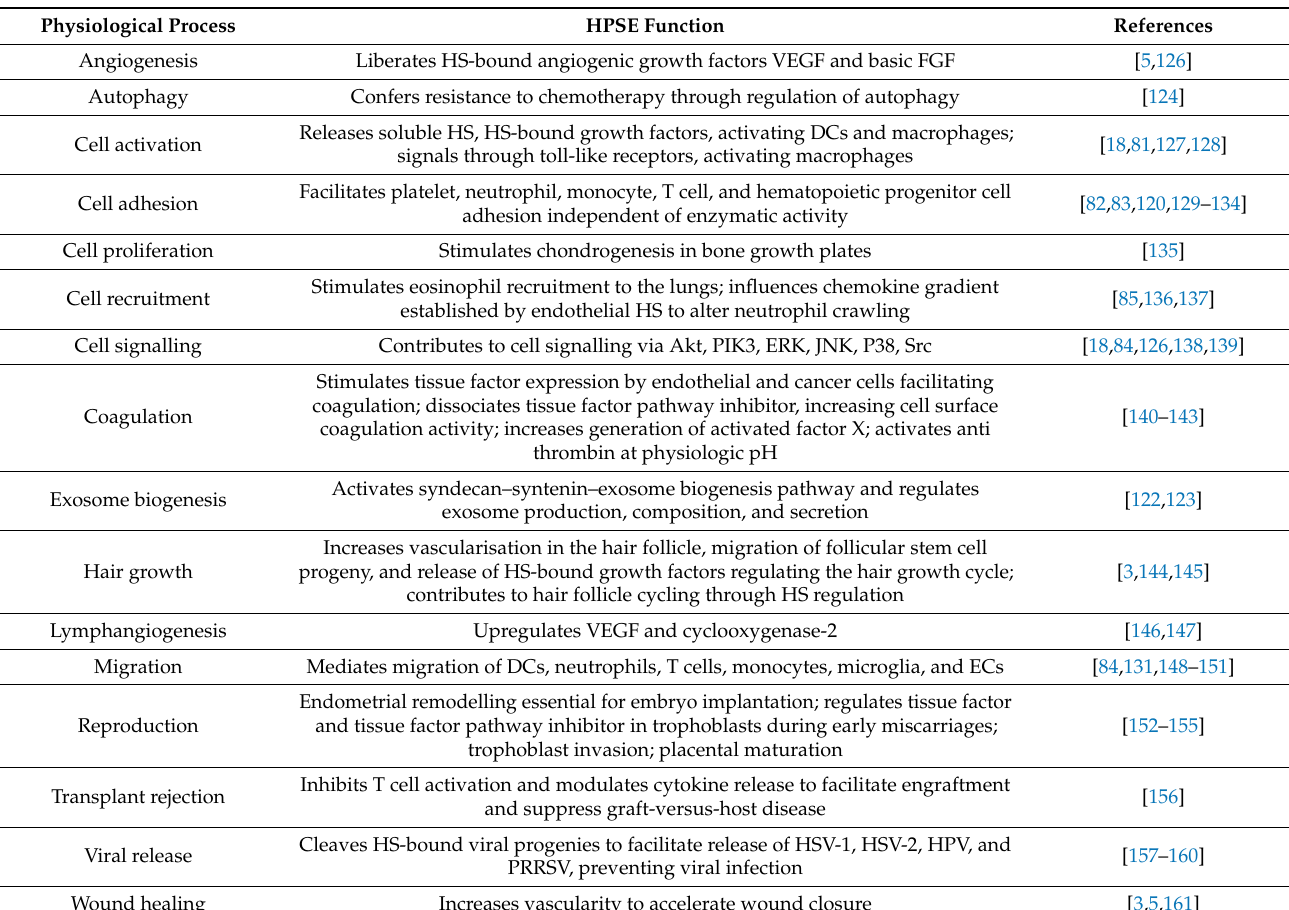
Table 1. HPSE functions in physiological